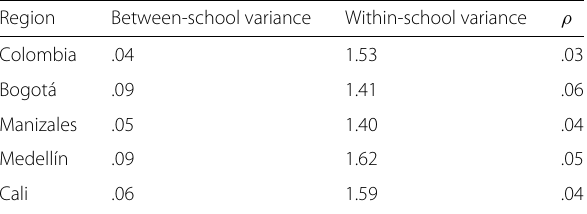
Table 3 Estimation of variance between and within schools and intraclass correlation ( ρ ) Region Between-school